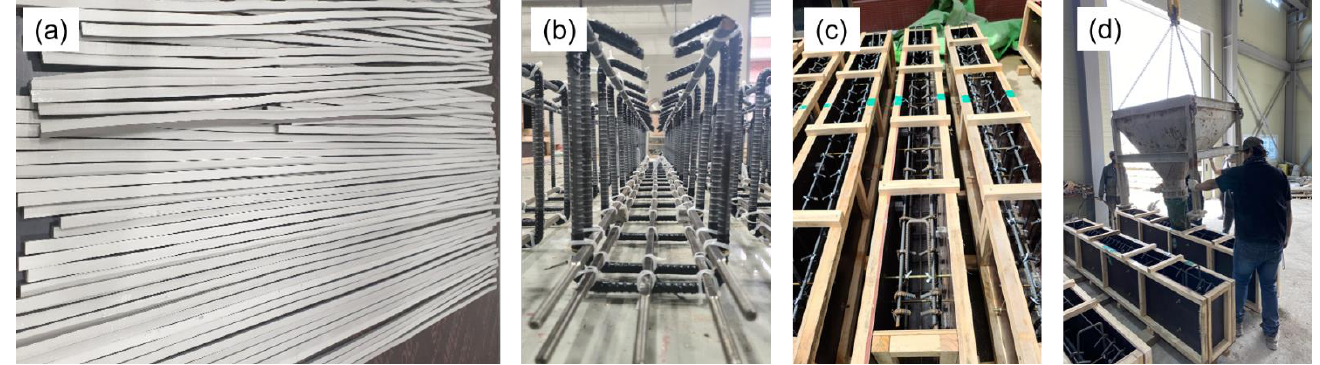
Figure 2. Photos of ( a ) Fe-SMA bars used for the experiments, ( b ) Fe-SMA and stirrup assembly, ( c ) molding for concrete casting and ( d ) concrete casting process.